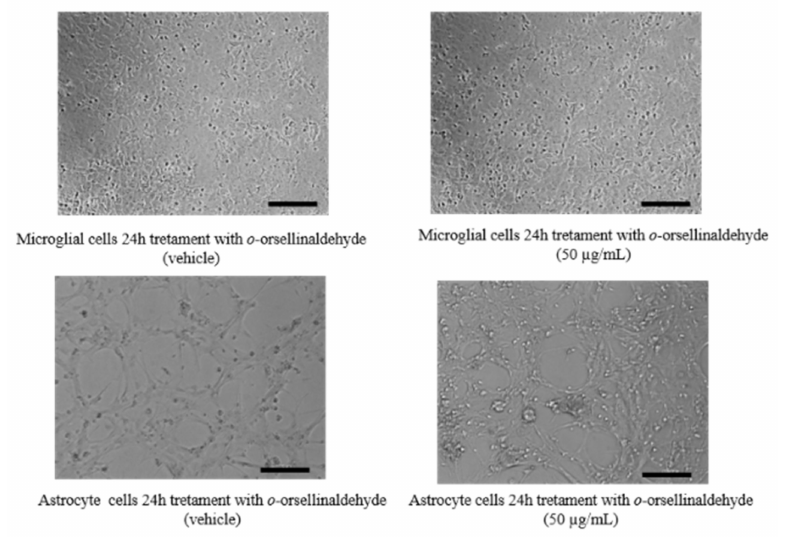
Figure 2. Effect of o -orsellinaldehyde on the morphology of astrocytes and microglia cells. Image captions of glial cells (astrocytes and microglia), untreated ( left ) or treated ( right ) with 50 µ g/mL of o -orsellinaldehyde for 24 h. Image scale bar = 10 µ